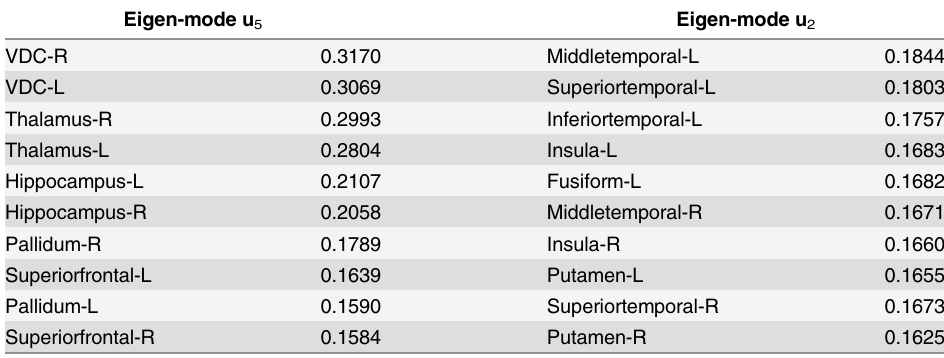
Table 1. Eigen-modes j u 5 j and j u 2 j (Fig 2(a) and 2(b)), and their dominant regions (Model